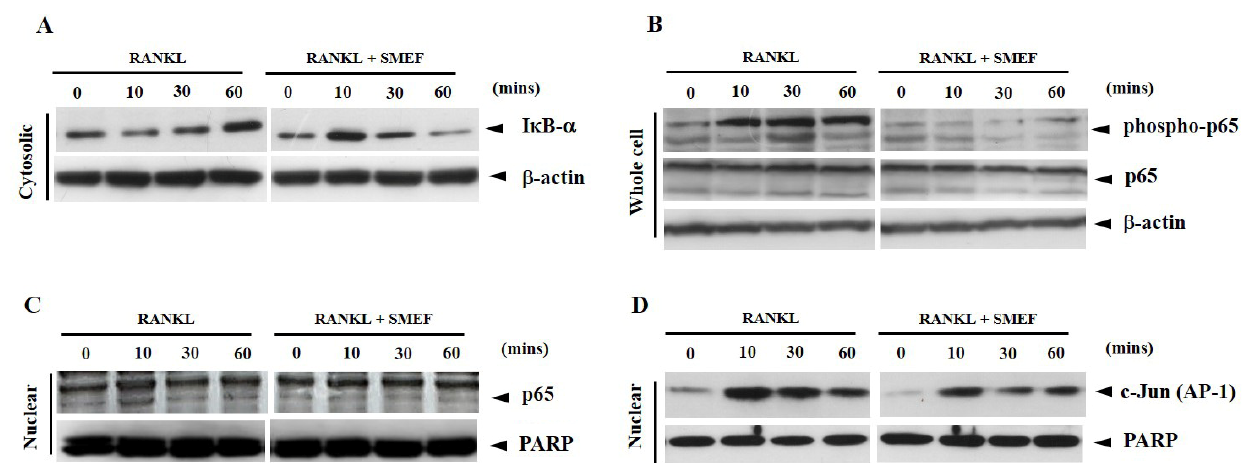
Figure 3. SMEF suppresses RANKL-induced NF- κ B and AP-1 activation after inducing with RANKL for indicated time. ( A – D ) RAW 264.7 cells were pretreated with SMEF (50 µ g/mL) for 12 h and then exposed to RANKL for 0, 10, 30, and 60 min. Cytosolic fractions were analyzed for protein content of I κ B- α degradation, whole-cell lysates were used to determine phosphorylation levels of NF- κ B p65, and nuclear fractions were analyzed for NF- κ B p65 and AP-1(c-Jun) translocation (assayed by Western blotting as described in the Materials and Methods section).